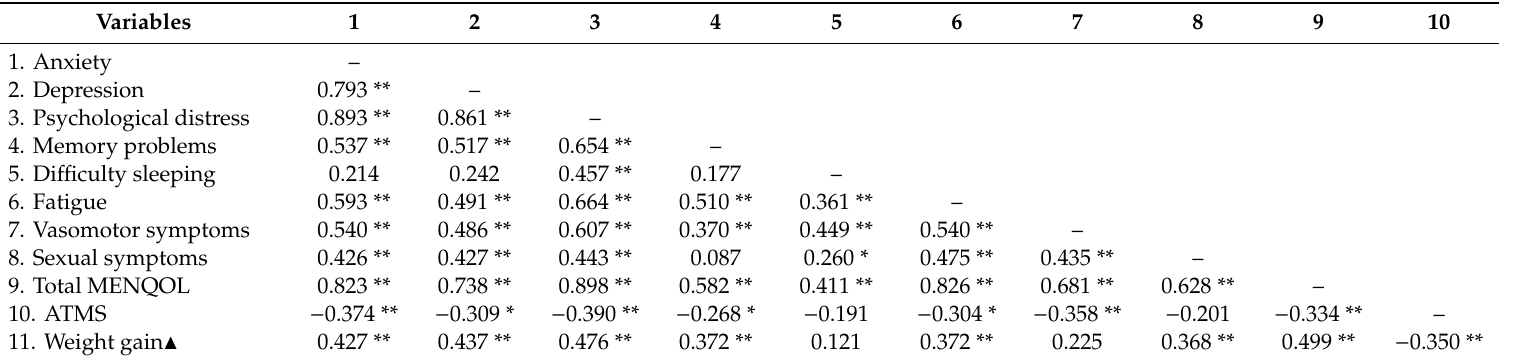
Table 2. Correlations between psychological variables and attitudes toward menopause with di ff erent menopausal symptoms.